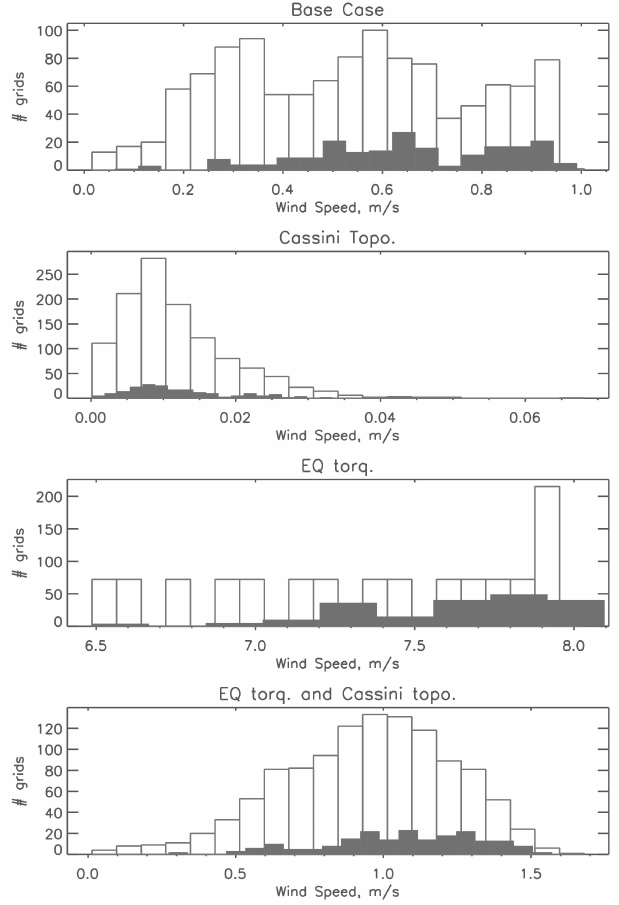
Figure 7. Average wind speed histograms of the simulations during one Titan year. Outlines indicate all of Titan, while the shaded region indicates grid cells with